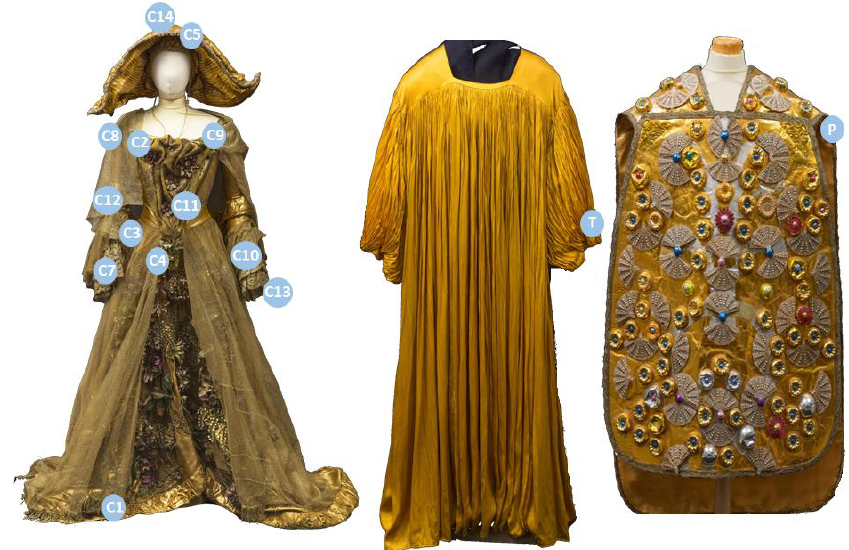
Figure 1. The “golden lady” costume in “Il Casanova” ( left ); tunic ( center ) and chasuble ( right ) of a bishop in “ Roma .” The sampling locations are labeled in light blue.